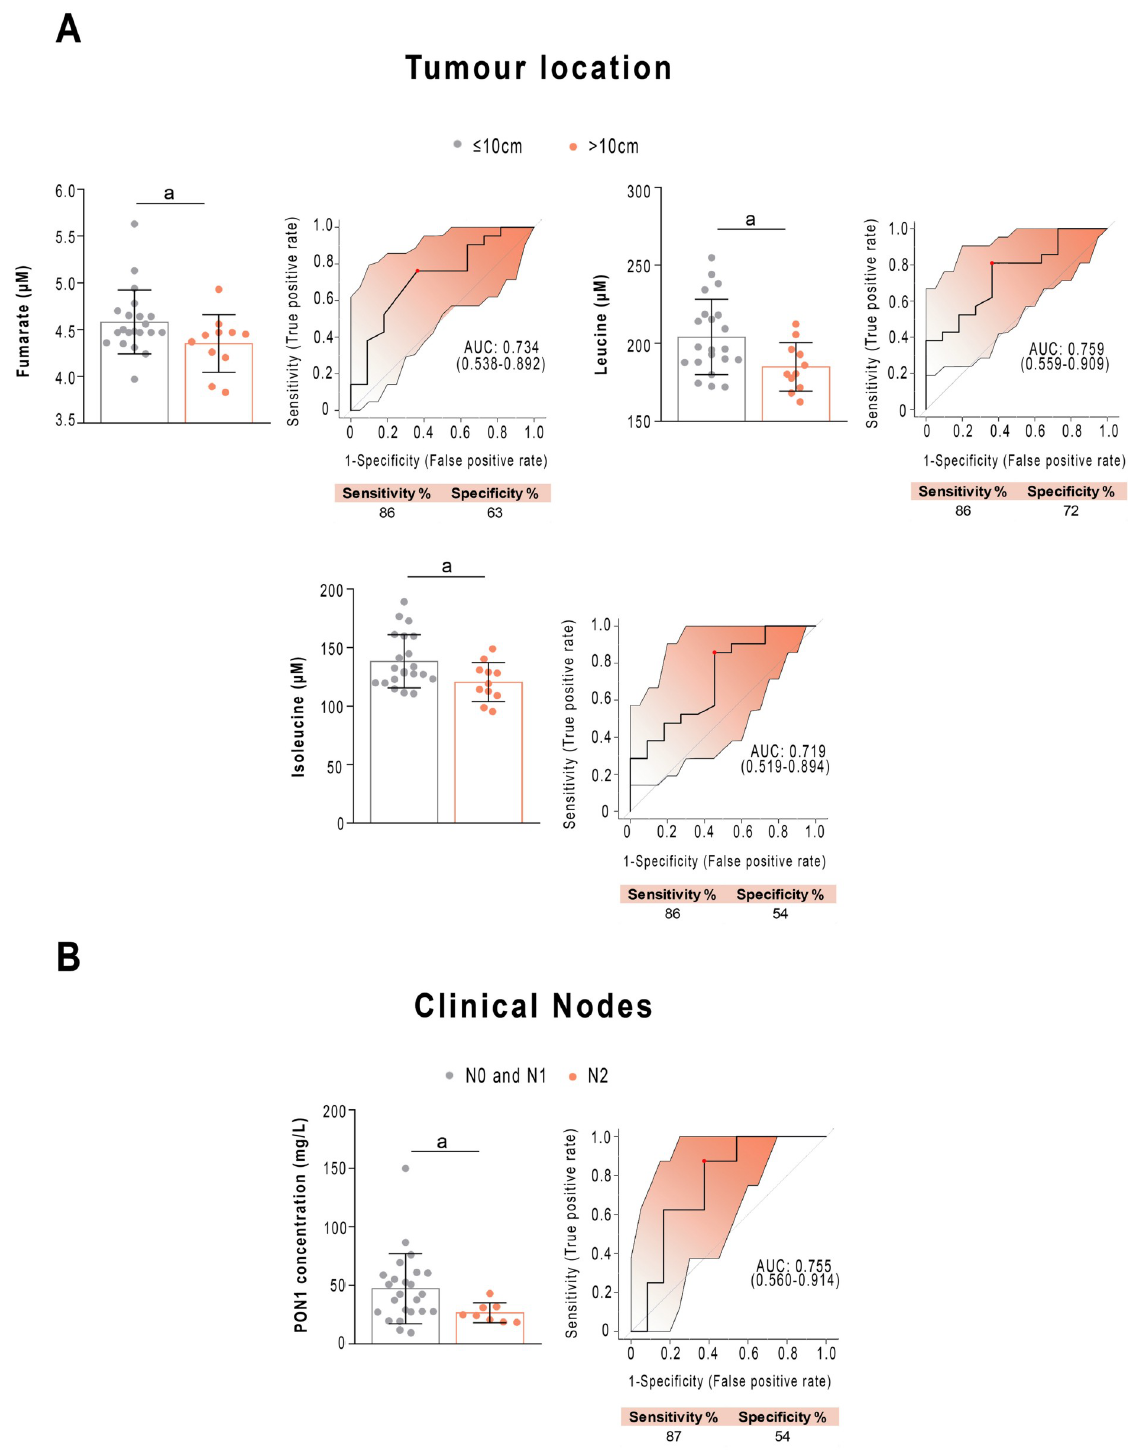
Fig 6. Selected metabolites and Paraoxonase-1 (PON1) concentrations are associated with clinical variables before treatment. (A) Receiver operating characteristics curve-based model evaluation showing that the combination of fumarate, leucine and isoleucine was able to efficiently distinguish tumour location near to ( < 5cm) or far from ( > 10cm) the anal margin in patients with rectal cancer. Confusion matrix showing the performance summary of the predicted results. (B) Receiver operating characteristics curve-based model evaluation showed that PON1 concentration was able to discriminate between patients with Nodes 0+1 vs . Node 2. Sensitivity and specificity are shown as percentages. AUC: Area under the curve. a = p < 0.05; b = p < 0.01.